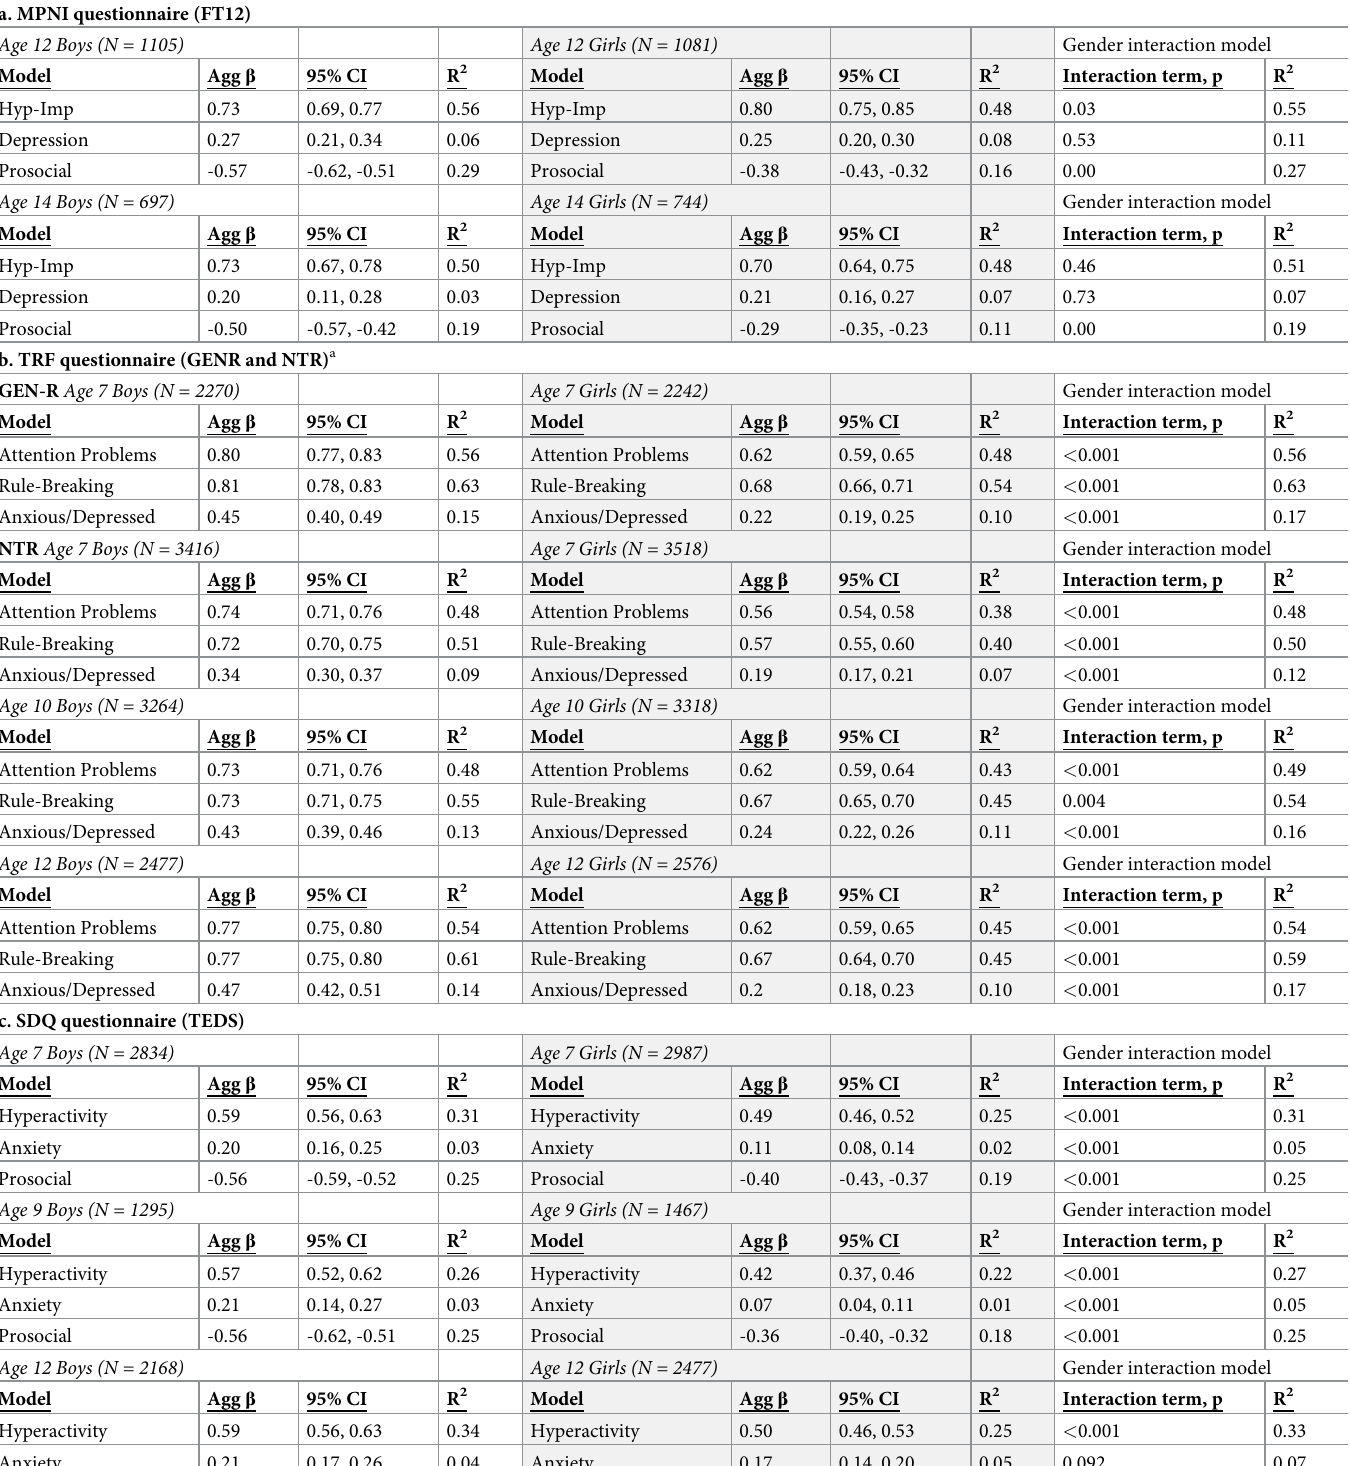
Table 1. (a-c) Linear regression summaries of standardized single independent variable models. Modeled separately by behavioral questionnaire, age wave of data collec- tion, and